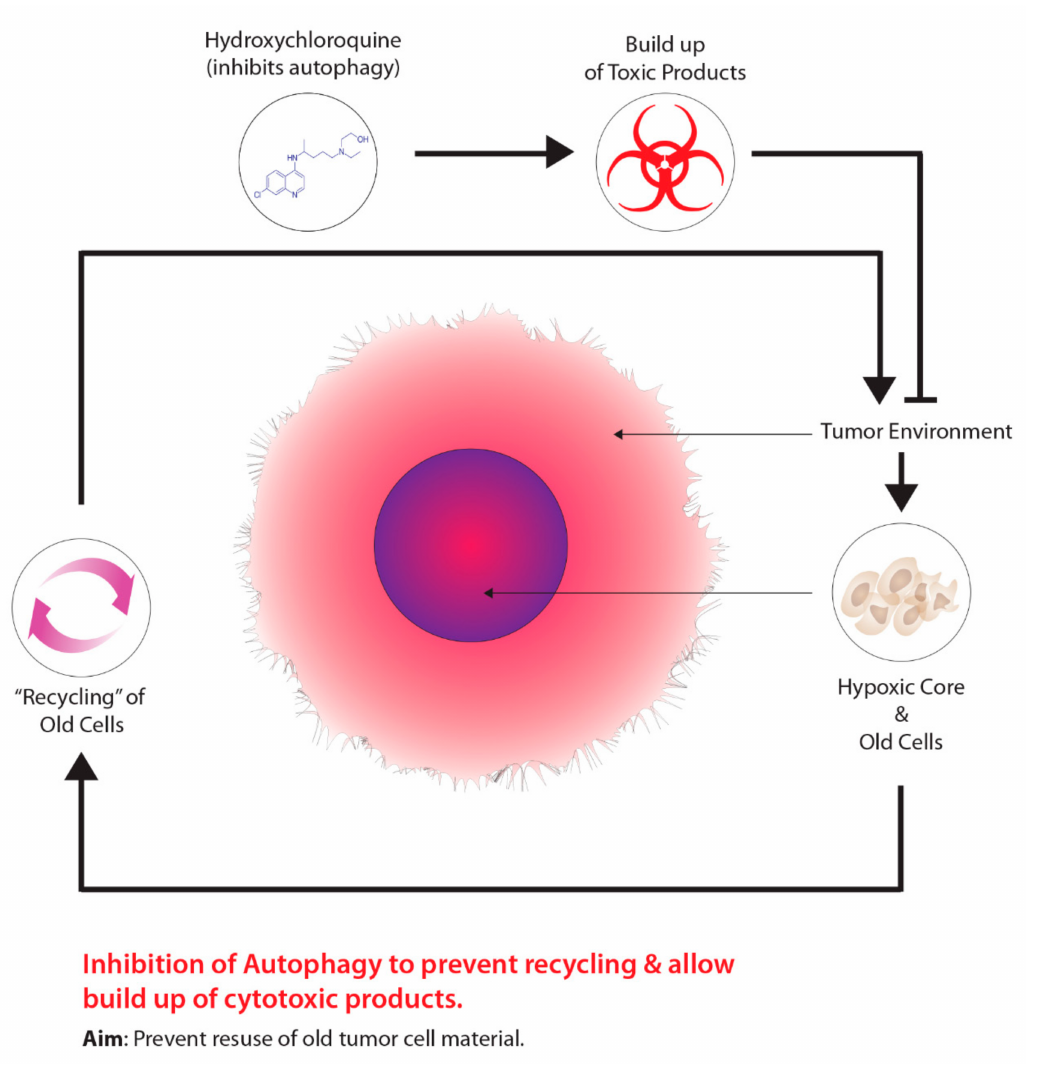
Figure 5. Harnessing autophagy to destroy hypoxic